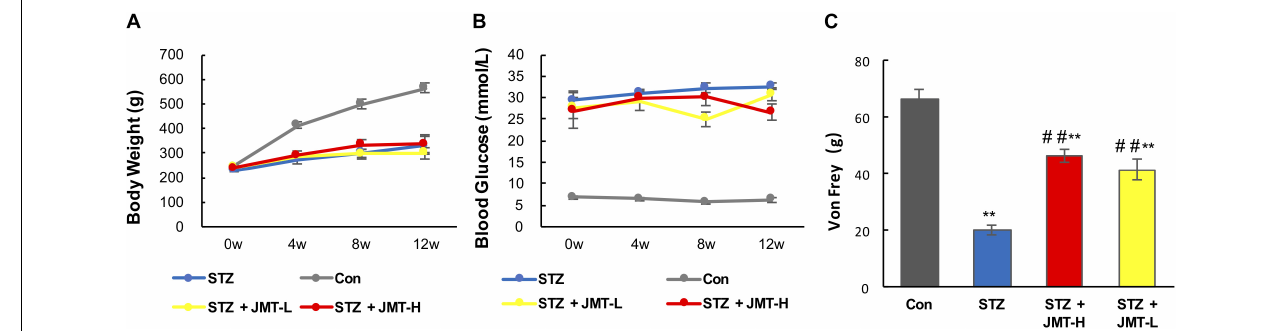
FIGURE 1 | Effects1pc of JMT on body weight (A) , blood glucose (B) , and Von Frey sensory testing (C) . Data are group mean ± SEM ( n = 6 per group). ## P < 0.01 vs. untreated diabetic rats; ** P < 0.01 vs. control rats by Student’s t-